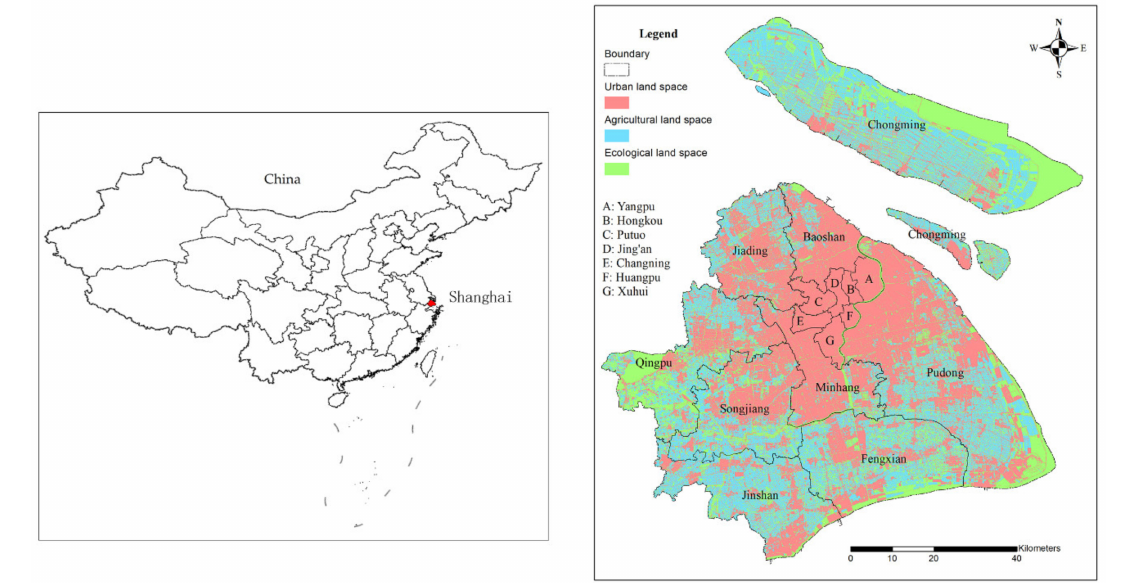
Figure 1. Distribution of the three types of land spaces in